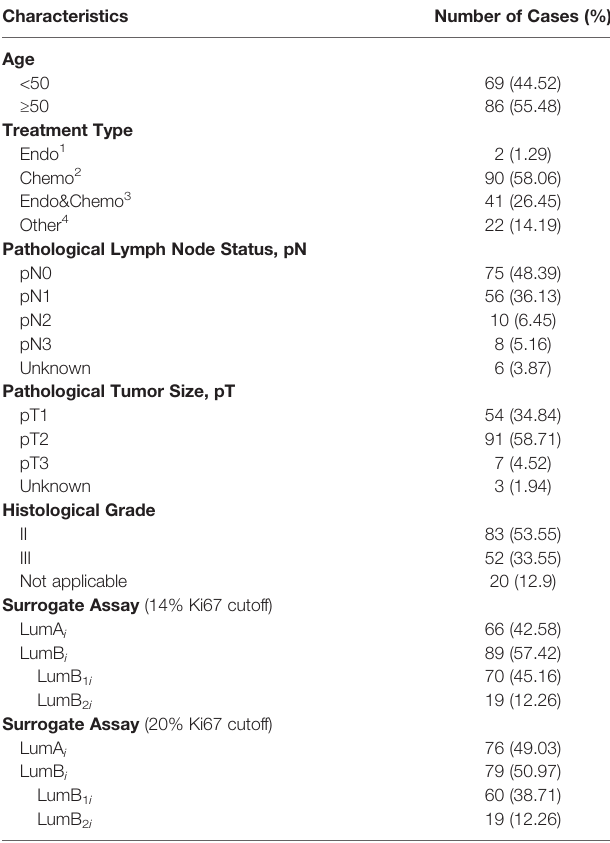
TABLE 1 | Clinicopathological characteristics of 155 Luminal-like breast cancer specimens.